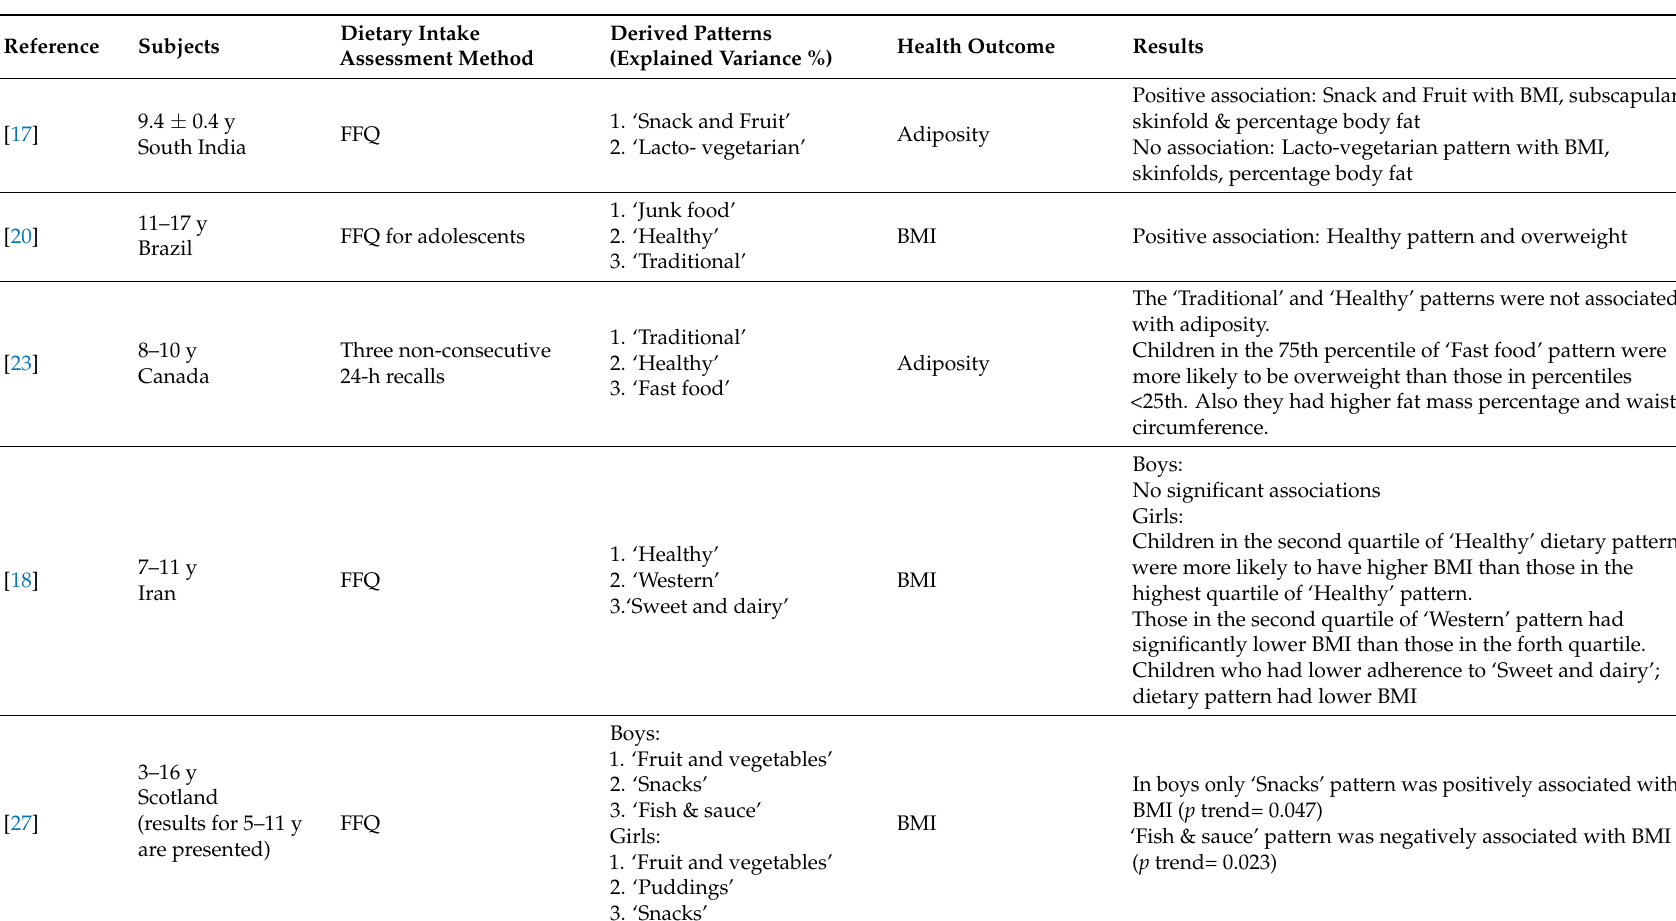
Table 1. PCA derived dietary patterns and their association with traditional CVD risk factors in